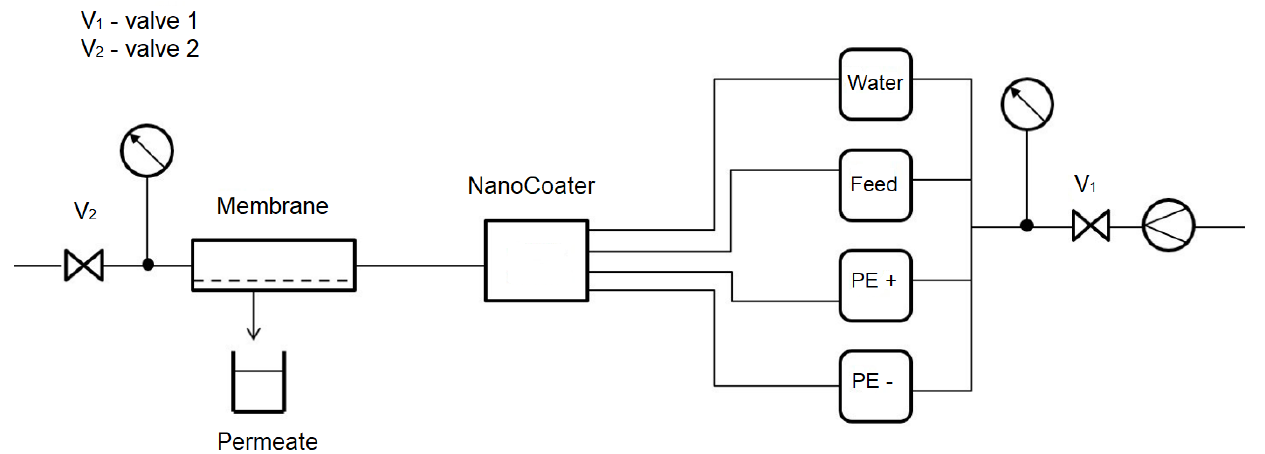
Figure 1. Principle of the NanoCoater process to generate hybrid membranes using the LbL technology [14].